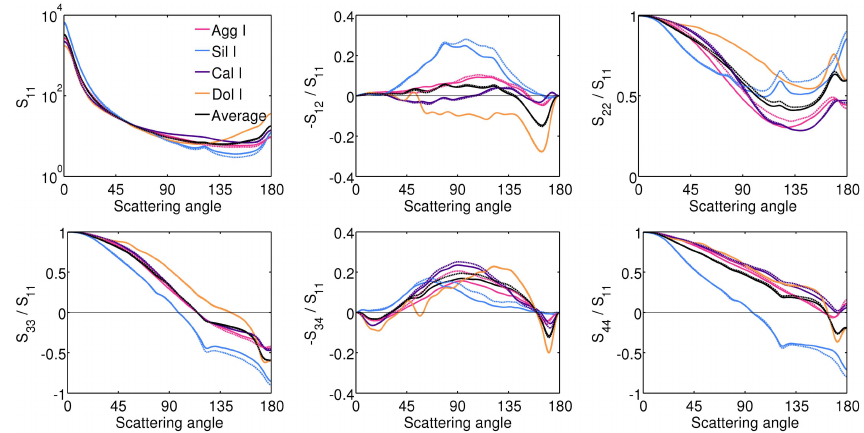
Fig. 10. Scattering results for a log-normal size distribution of inhomogeneous stereogrammetric shapes (solid lines). The effective-medium approximation results (homogeneous stereogrammetric shapes) are shown with dashed lines. Particle-averaged scattering properties are also presented.